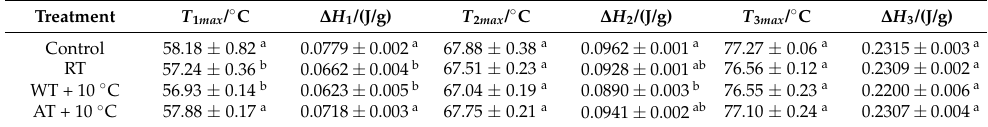
Table 5. Effects of different tempering methods on T max and ∆ H (the denaturation temperature and enthalpy of myofibrillar protein, respectively) of salmon. (RT: Radio frequency tempering; WT + 10 ◦ C: Water tempering at 10 ± 0.5 ◦ C; AT + 10 ◦ C: Air tempering at 10 ± 1 ◦